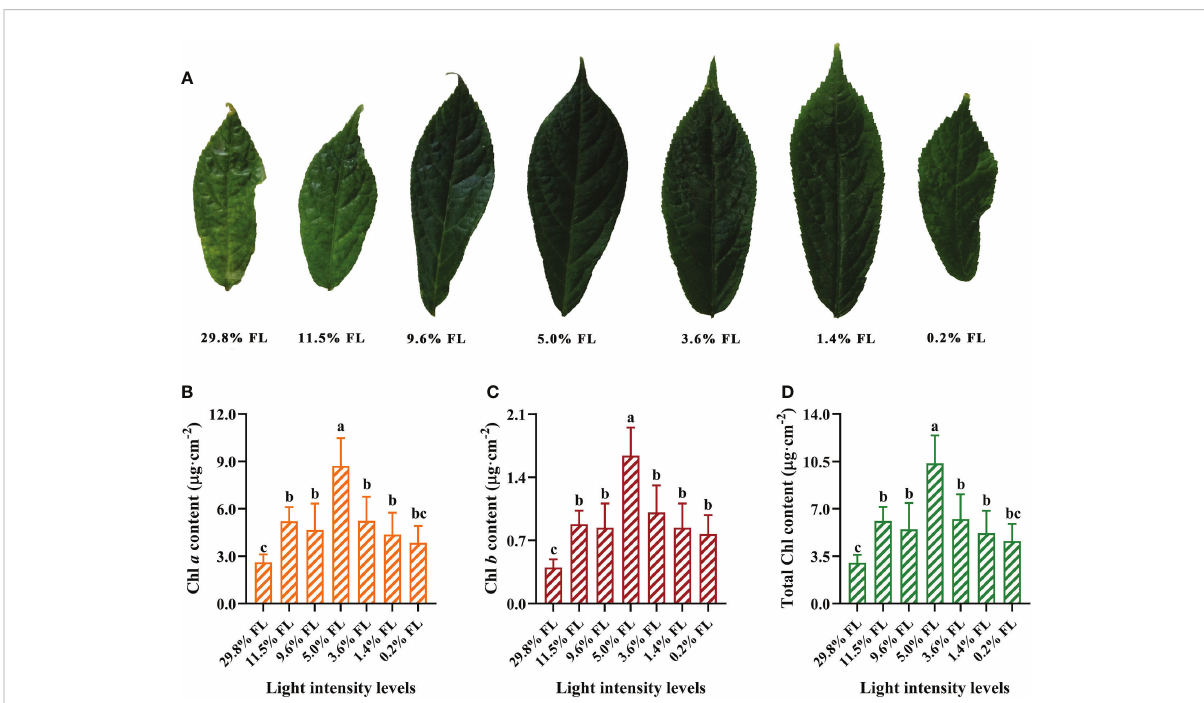
FIGURE 1 The effect of light regimes on leaf phenotypes (A) , cited from our research group (Zhang et al., 2021), chlorophyll a (Chl a ) content ( m g·cm -2 , B ), chlorophyll b (Chl b ) content ( m g·cm -2 , C ) and total Chl content ( m g·cm -2 , D ). Values for each point were means ± SD ( n = 7). Letters indicate signi fi cant differences at P < 0.05 according to Duncan ’ s multiple range